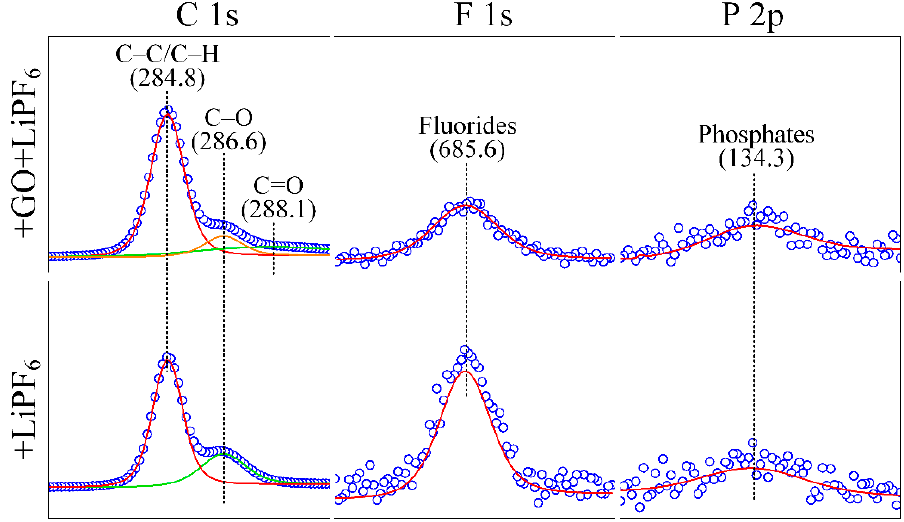
Figure 6. Chemical state of worn areas on Si 3 N 4 balls with the lubrication of various solutions.